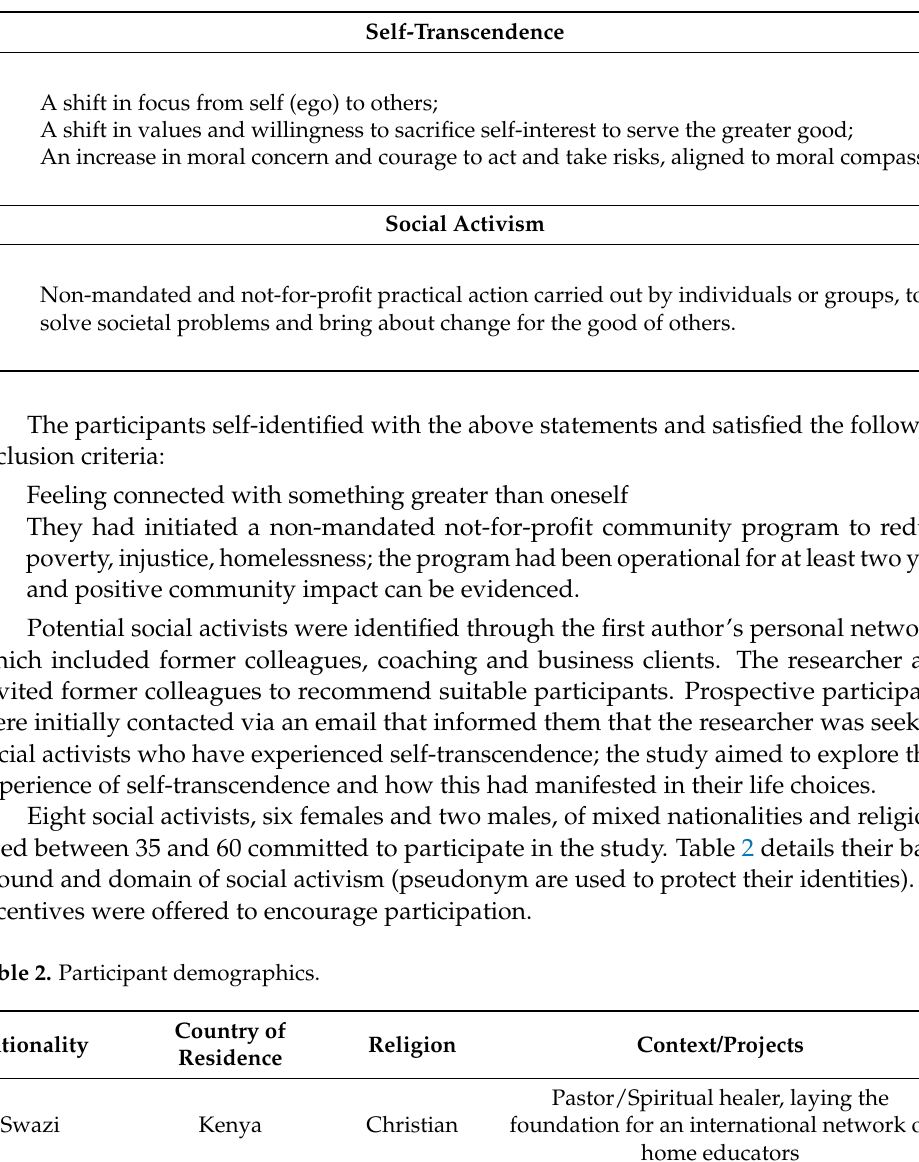
Table 1. Definitions used for purpose of recruitment.